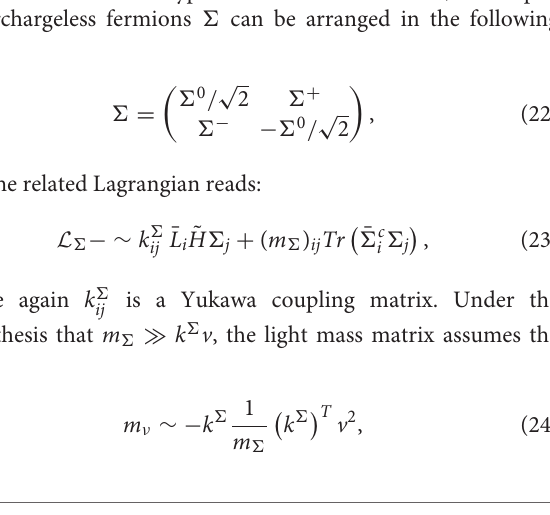
The type-I see-saw mechanism shows that the light neutrino masses depend quadratically on the Dirac masses but are inversely proportional to the large Majorana mass, so that the scale of new physics is clearly 3 M =